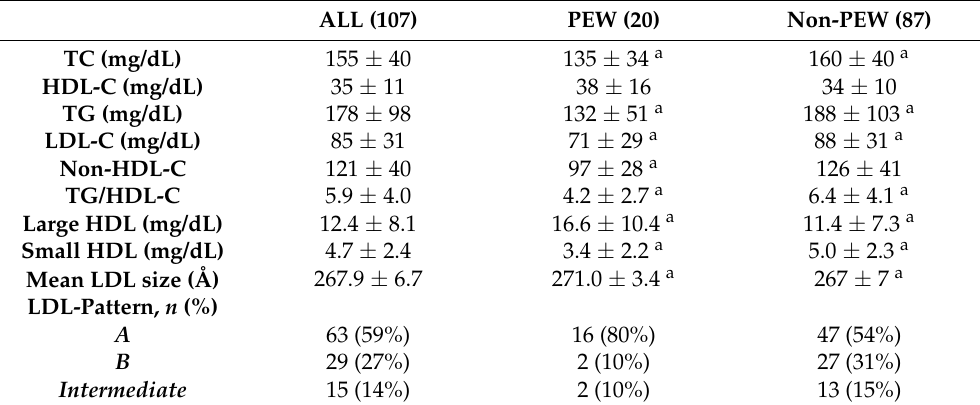
Table 4. Lipid profile and sub-fraction analyses: PEW versus Non-PEW